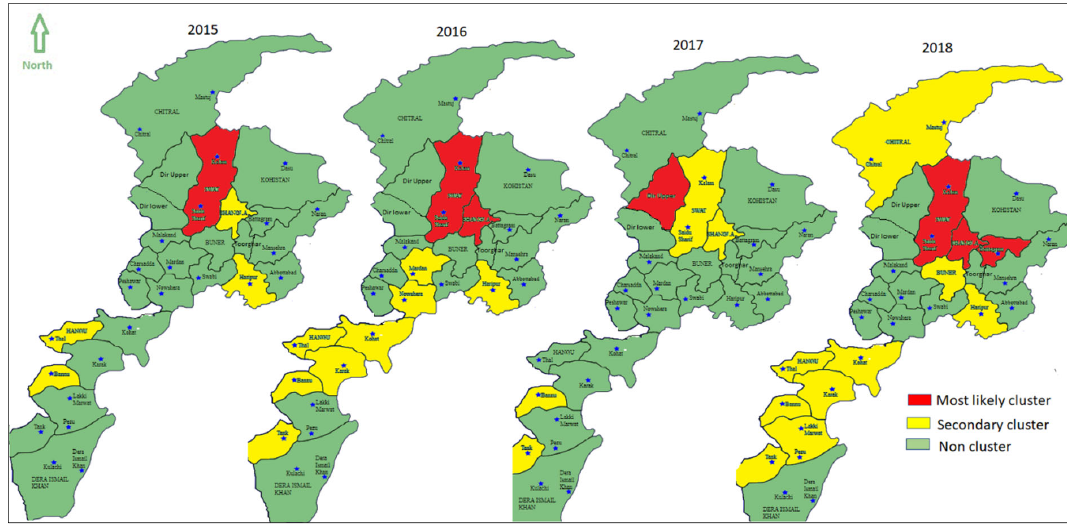
Figure 3. The locations of spatial clusters in the study area.